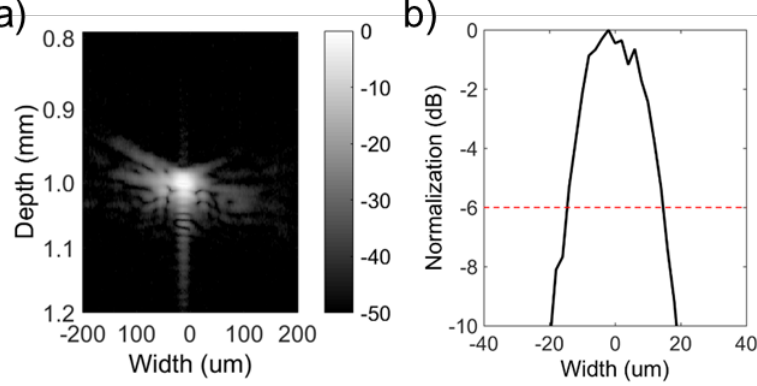
Figure 6. ( a ) Image of 10 μm tungsten wire target; (b) Lateral beam profile of the Co-doped Na 0.5 Bi 4.5 Ti 4 O 15 (NBT-Co) transducers.